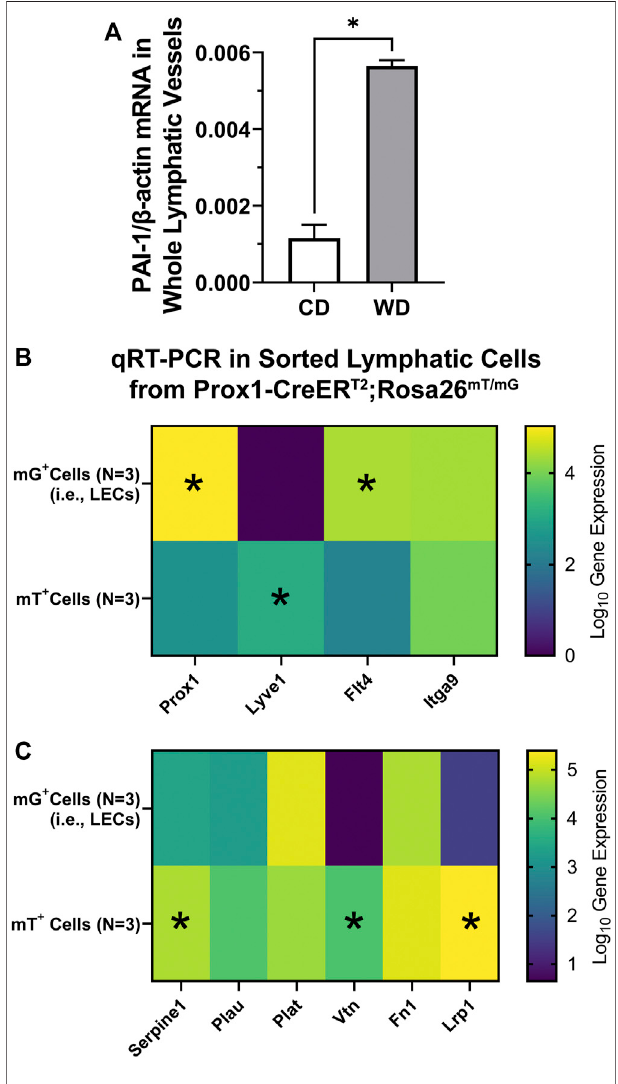
FIGURE 7 | PAI-1 is expressed throughout the lymphatic wall and upregulated in diet-induced obesity. (A) PAI-1 mRNA expression (normalized by β -actin) assessed using ddPCR in whole mesenteric lymphatic vessels from control diet (CD) and western diet (WD) fed WT mice; (B, C) gene expression for various LEC-associated and PAI-1 associated genes using qRT-PCR on sorted mG + (i.e., LECs) and mT + cells from Prox1-CreER T2 ; Rosa26 mT/mG reporter mice. Data is presented as mean ± SEM. Statistically signi fi cant differences were evaluated using parametric t tests. * p < 0.05 for mG + vs. mT +